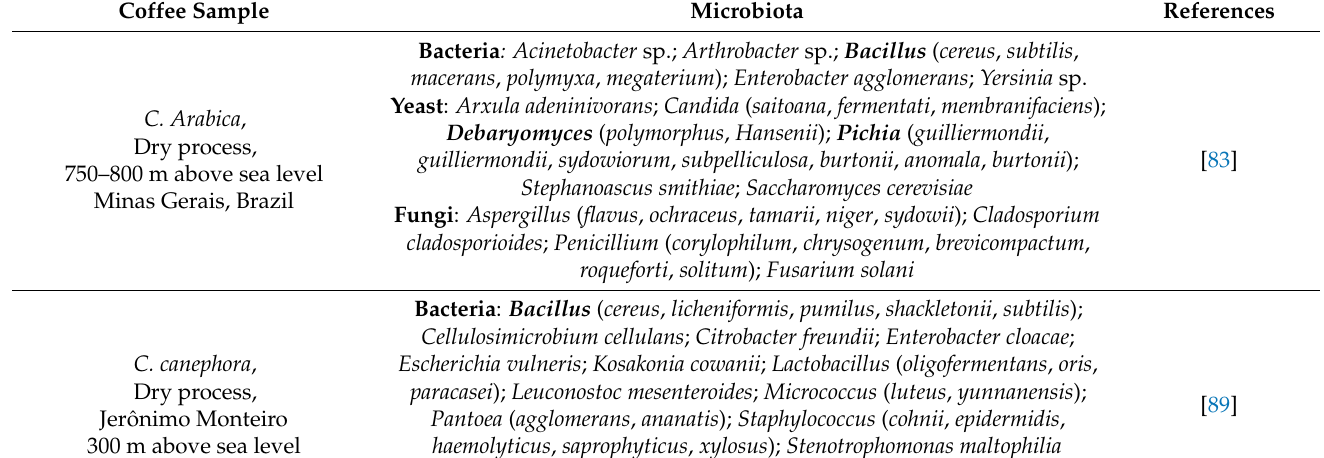
Table 2. Microorganisms isolated during coffee fermentation in dry, wet, or semi-dry processes. Coffee